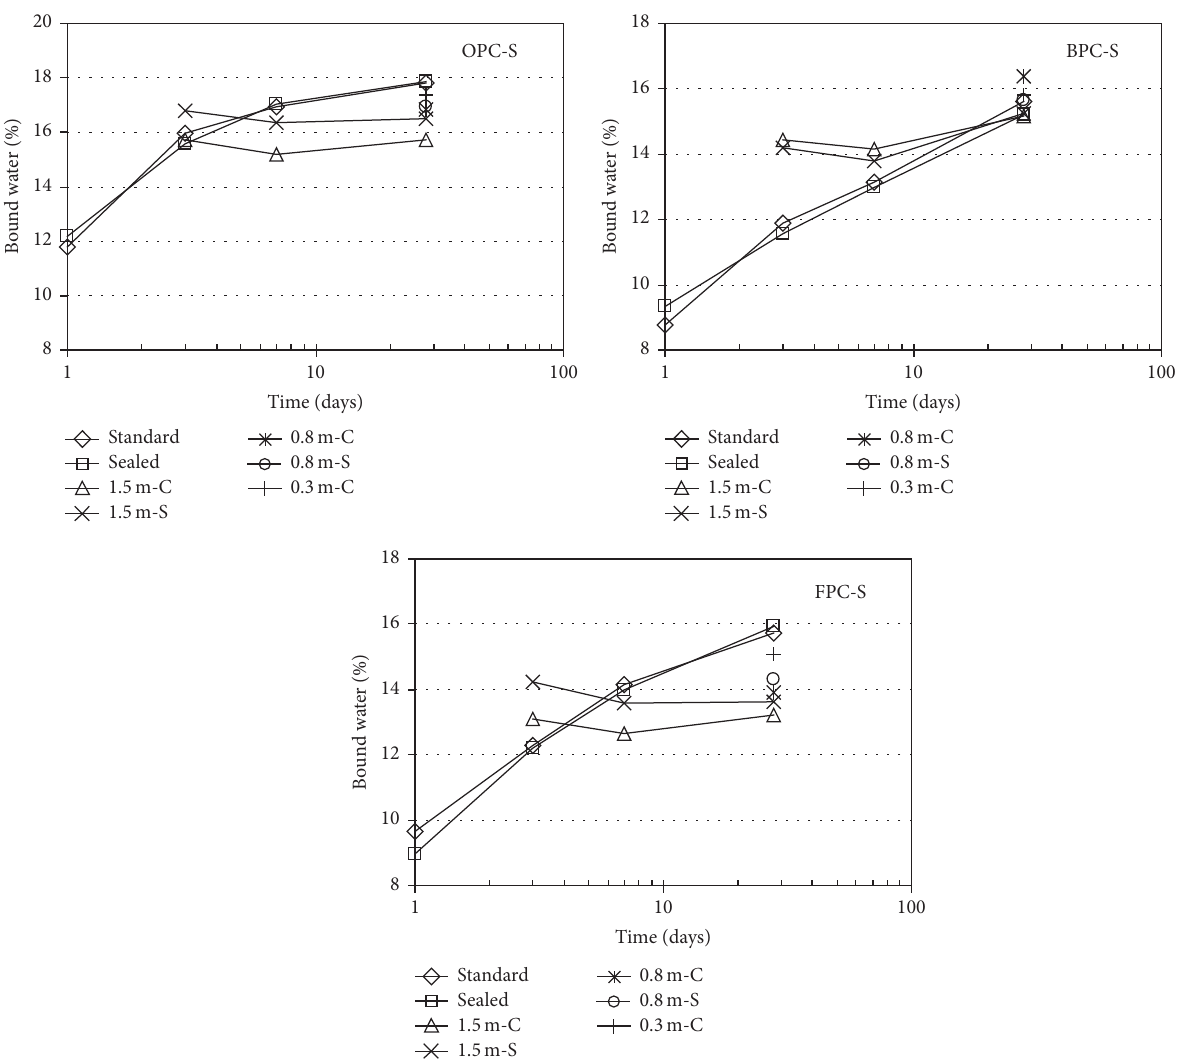
Figure 5: Effect of temperature on the bound water of concrete in summer